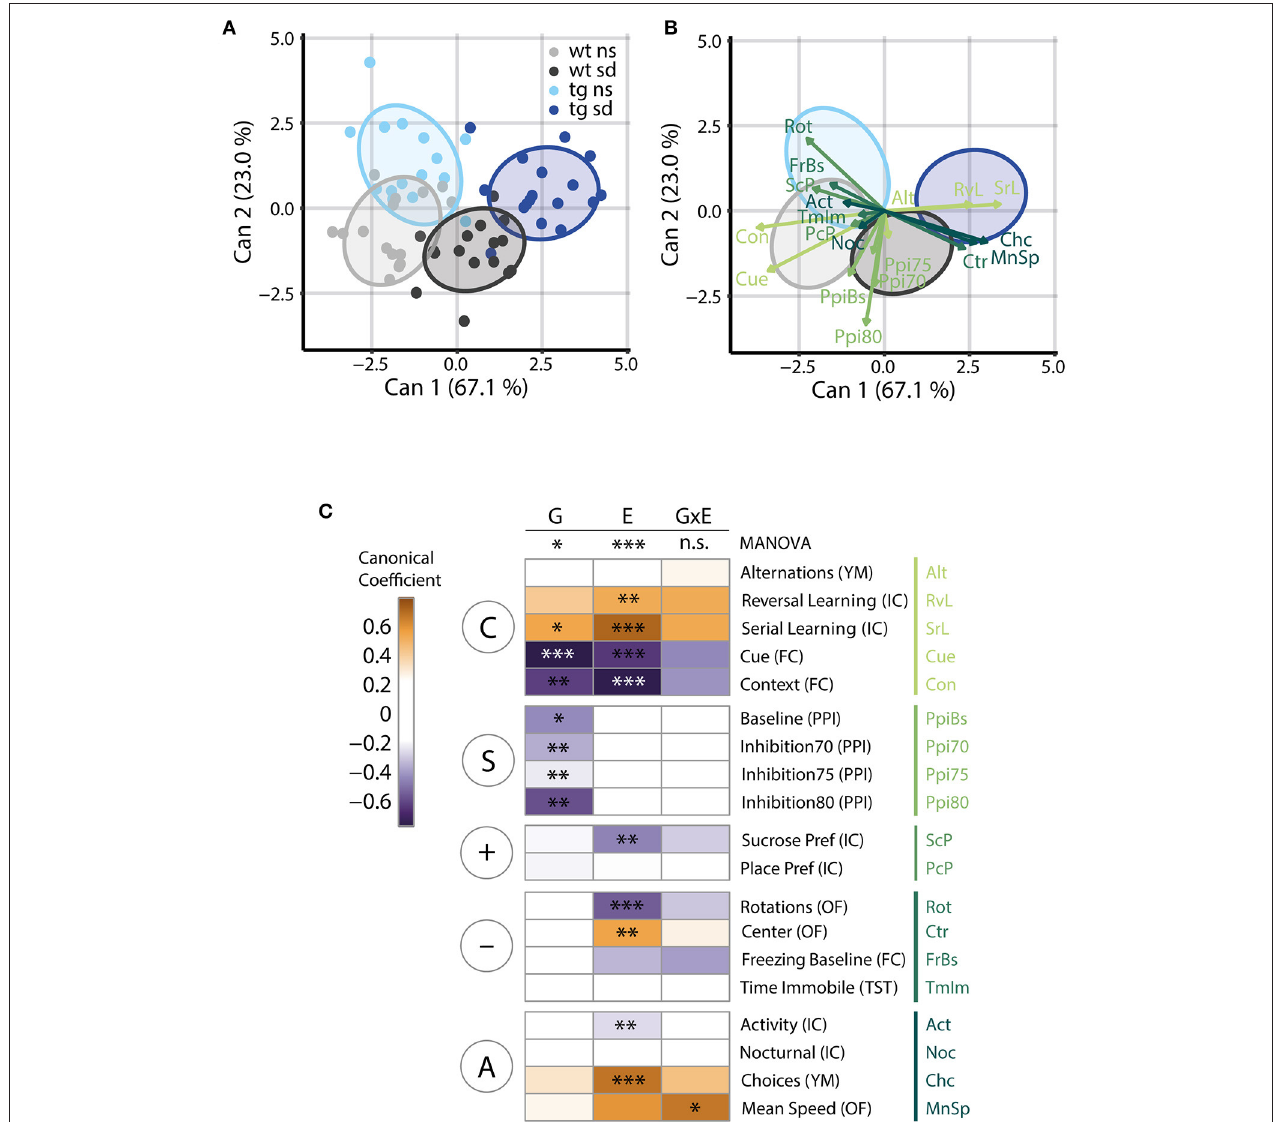
FIGURE 6 | Canonical discriminant analysis reveals striking group differences modulated by genetic and environmental factors. (A) Canonical Discriminant Analysis (CDA) of the collective data reveals that the stronger canonical component 1 (Can1), which explains 67.1% of the total canonical correlation, separates the datapoints along the environmental factor, while the second component, amounting to 23.0% of canonical correlation, separates the datapoints according to Tcf4 gene dosage. Ellipsoids visualize 75% coverage of each group and each animal is depicted as correspondingly colored dot; n = 15/17/15/17. (B) The CDA dimension plot depicted without individual data points but with vector representations of canonical coefficients instead, indicates the contribution of single variables to the structure of each canonical component. Several measures of cognitive ability influence both components, among them contextual and cued fear memory, while novelty-induced activity, as measured with mean speed in the open field and choices in the Y-maze, mainly separate psychosocially stressed animals from controls. Sensorimotor gating disturbance appears to be a trait of Tcf4 gain of function, again. (C) A heatmap displaying the contribution of each variable to the separation along each term of the linear model of the CDA in a color code shows RDoC domain-specific differences in the contribution of gene and environment to the observed group separation. The asterisks indicate the adjusted p -value of significant terms of the univariate ANOVAs displayed in Figures 2 – 4 . In summary, the MANOVA reveals a significant effect of gene dosage (“G”), in the form of Tcf4 overexpression, on the neurocognitive profile of our model [ F (19,31) = 2.52, p = 0.011] as well as a clear effect of the environment (“E”), i.e., social defeat [E: F (19,31) = 7.83, p = 3.32E-7]. These effects appear to be additive, but overall, no statistical interaction of gene and environment (“G × E”) was found [ F (19,31) = 1.41, p = 0.194]. Again, grouping of the variables in RDoC domains shows a strong influence of social defeat on positive (“ + ”) and negative (“–”) valence systems as well as regulatory and arousal systems (“A”). Tcf4 gene dosage has a major impact on sensorimotor systems (“S”). While G has no significant influence on arousal by itself, the G × E interaction is significant in Mean Speed. Both factors contribute to the separation of groups by their cognitive performance (“C”). Column blocks are defined by RDoC domains. n = 15/17/15/17. The F statistics given refer to a Wilk’s lambda approximation based two-way MANOVA.